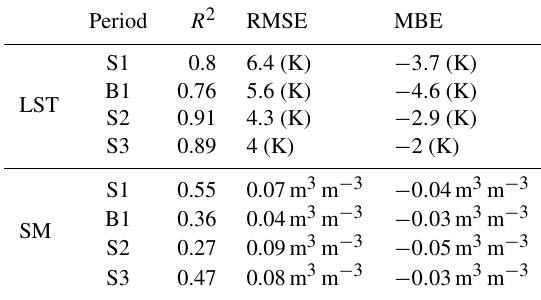
Table 3. Validation results of DisPATCh SM and MODIS LST at the Sidi Rahal